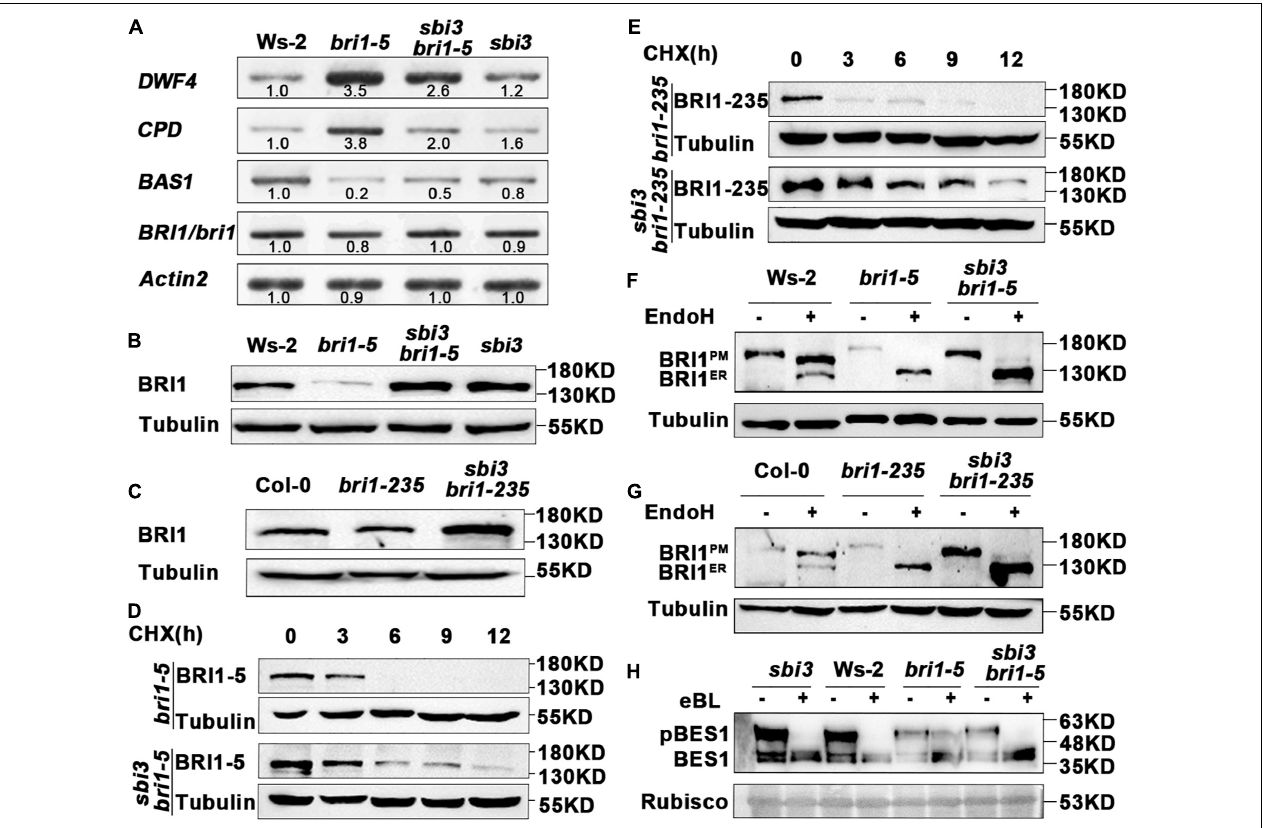
FIGURE 4 | sbi3 mutation inhibits the Endoplasmic Reticulum-Associated Degradation (ERAD) of bri1-5 and bri1-235 through a posttranscriptional mechanism. (A) The expression abundance of transcripts for BR receptor BRI1 in Ws-2, bri1-5 , sbi3 bri1-5, and sbi3 seedlings was detected by semi-quantitative RT-PCR. The transcripts of BRI1/bri1 in the wildtype (WT) or the mutant were similar. Actin2 was used as an internal control. N = 3 biological replicates. (B) Western blot analysis of BRI1 protein abundance in Ws-2, bri1-5 , sbi3 bri1-5, and sbi3 . Extracts were prepared from 14-day-old seedlings grown in 1/2 MS medium. Specific antibodies: Anti-BRI1, Anti-Tubulin (control). (C) Immunoblot analysis of BRI1 protein abundance in Col-0, bri1-235, and sbi3 bri1-235 . Specific antibodies: Anti-BRI1; Anti-Tubulin (control). (D) Immunoblot analysis of BRI-5 stability in sbi3 bri1-5 with the anti-BRI1 antibody. Two-week-old seedlings were treated with 180 µ M CHX for indicated incubation times. (E) Immunoblot analysis of BRI1-235 stability in sbi3 bri1-235 with the anti-BRI1 antibody. Two-week-old seedlings were treated with 180 µ M CHX for indicated incubation times. (F) Endoglycosidase H (EndoH) analysis of Ws-2, bri1-5 , sbi3 bri1-5 , sbi3 . BRI1 ER is the ER-localized proteins form, while BRI1 PM denotes the localization of BRI1 proteins in the plasma membrane. (G) EndoH analysis of Col-0, bri1-235, and sbi3 bri1-235 . (H) Immunoblotting of eBL induced dephosphorylation of sbi3 , Ws-2, bri1-5, and sbi3 bri1-5 . Rubisco served as a loading